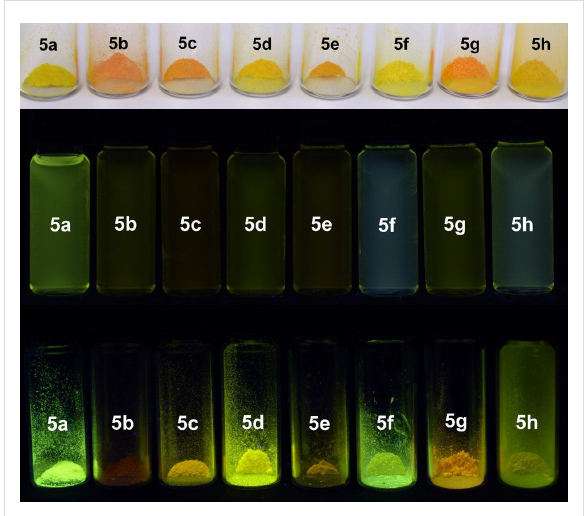
Figure 3: 1 H -Pyridine derivatives 5 as solids under daylight (top), under UV light ( λ exc = 365 nm, c ( 5 ) = 10 − 4 M) in dichloromethane solu- tion (center), and under UV light ( λ exc = 365 nm) in the solid state